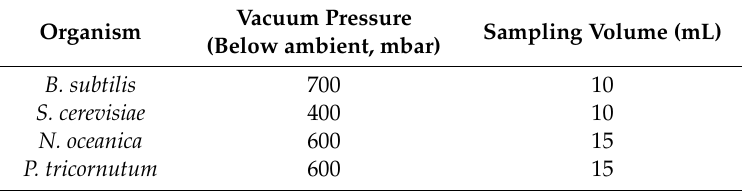
Table 1. Sampling parameters employed for Bacillus subtilis , Saccharomyces cerevisiae , Nannochloropsis oceanica, and Phaeodactylum tricornutum , including vacuum pressure, sampling volume and filter